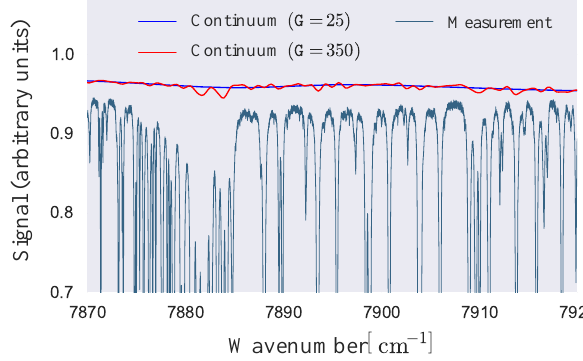
Figure 10. Excerpt of the Q-branch in the O 2 spectral window. For G = 350, the continuum starts to curve into broad solar absorption